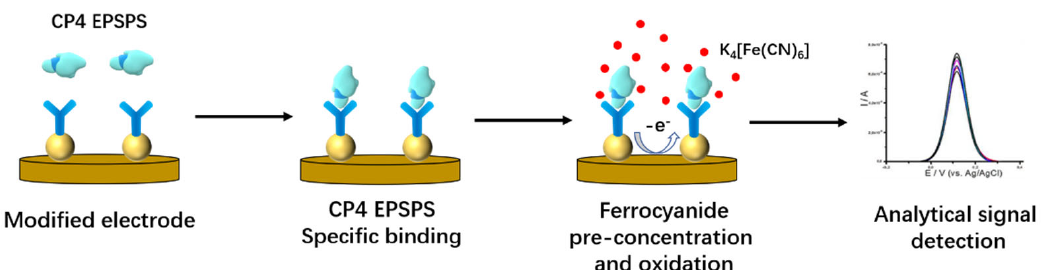
Figure 16. Schematic diagram of the electrochemical immunosensor for the detection of CP4 EPSPS (Adapted with permission from Ref. [71]. 2022, Marcos et al.).